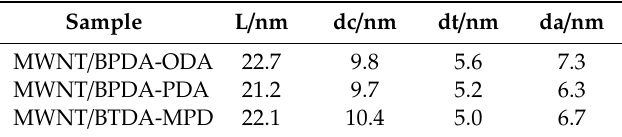
Figure 6. ( a ) Guinier law analysis of scattering curve of the aligned MWNT / PI nanocomposites. ( b ) X-ray diffraction (XRD) diagram of PI with three different molecular structures. Table 1. Statistical data of one-dimensional correlation